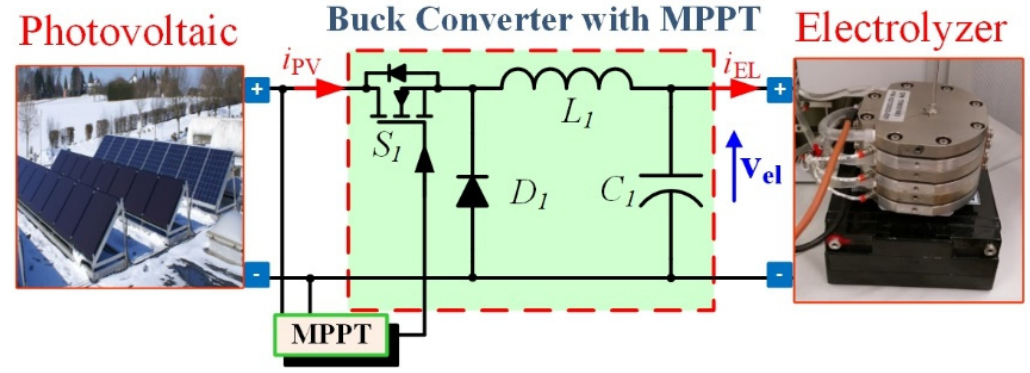
Figure 4. Hydrogen production systems supplied by solar energy.